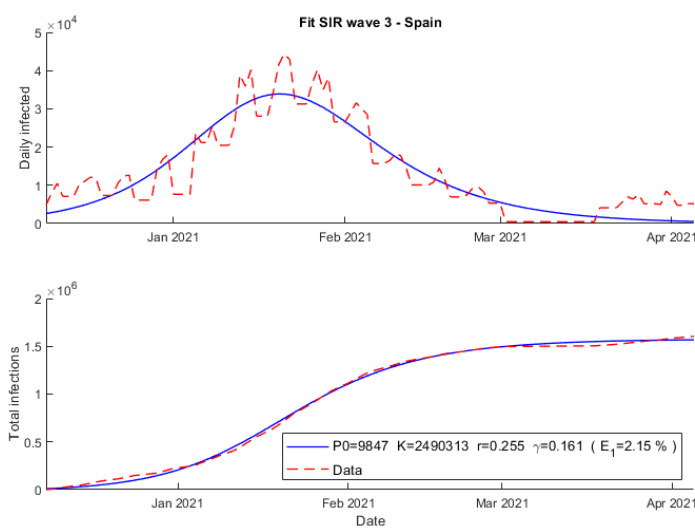
Figure 6. Fit using SIR model wave 3 COVID-19 Spain.